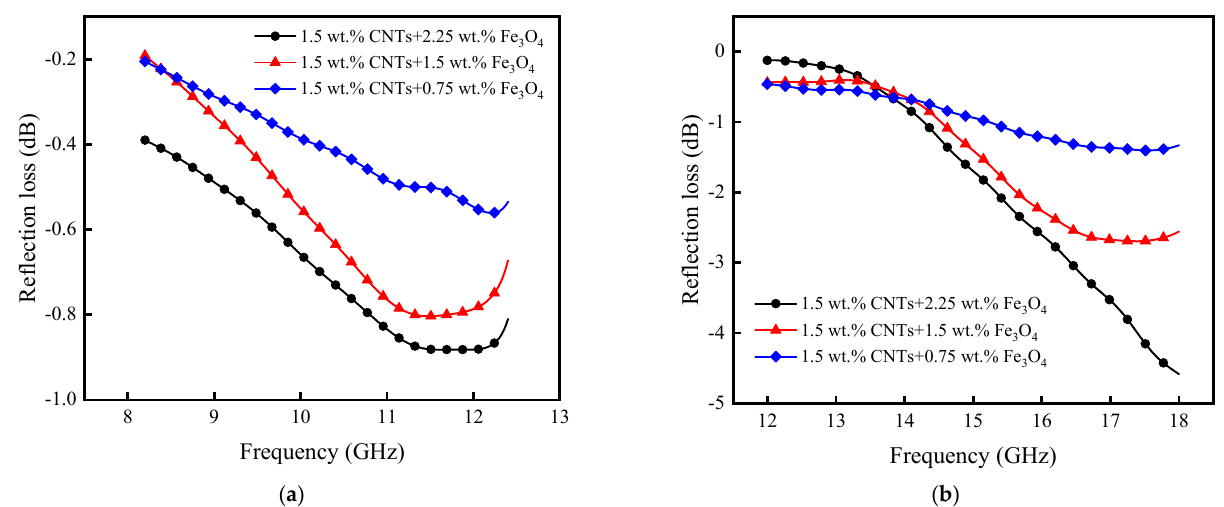
Figure 12. The influence of different mass ratio of CNTs and Fe 3 O 4 on microwave-absorbing performance of Fe 3 O 4 /CNTs/PU/PET gradient composites, with composites face up: ( a ) 8.2–12.4 GHz; ( b ) 12–18 GHz.